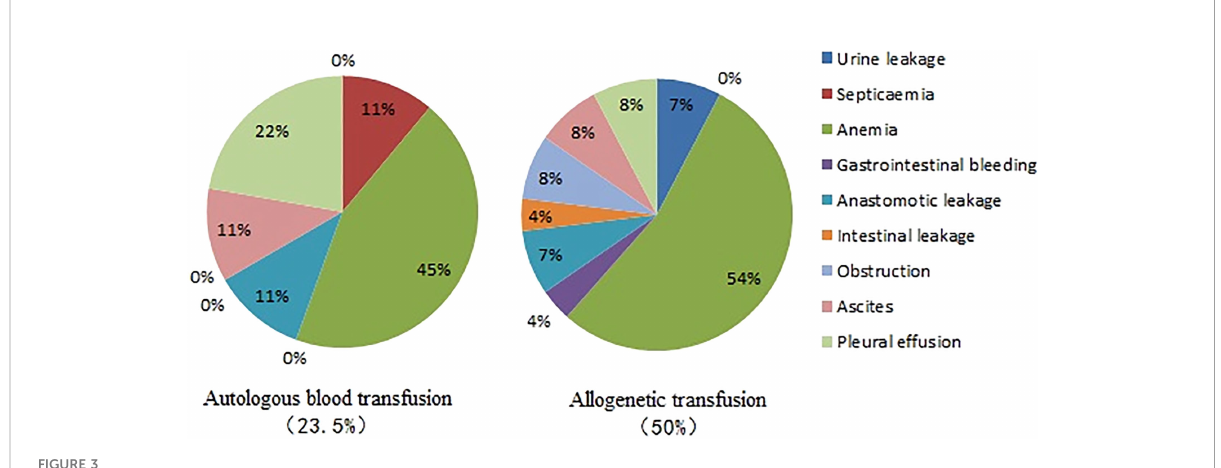
FIGURE 3 Distribution of serious adverse events in the two